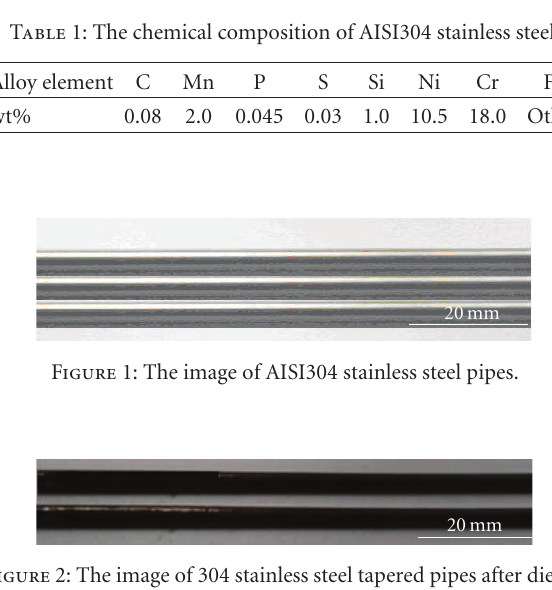
Figure 3: Thickness distribution of oxidation film on tapered pipes surface at the di ff erent induction heating